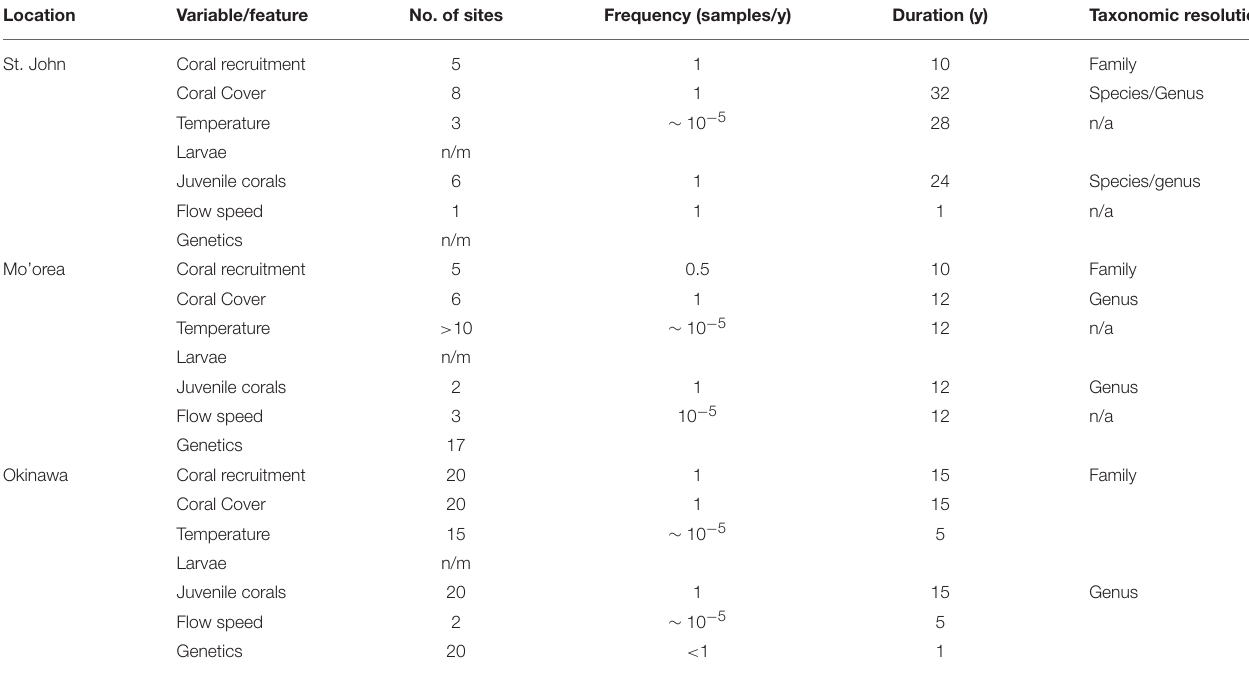
TABLE 2 | Summary of concordance and mismatches among data types originating from time-series analyses of coral reef communities around three CRI, St. John, Mo’orea, and Okinawa. Location